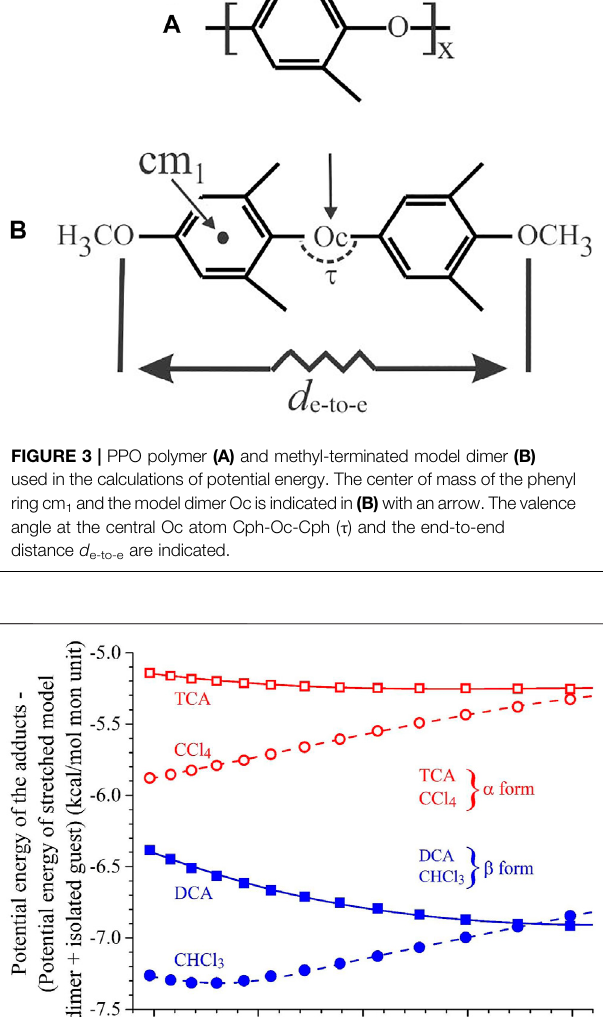
TABLE 3 | Guest solubility in 100 ml of water vs corresponding crystalline forms. Guest molecules